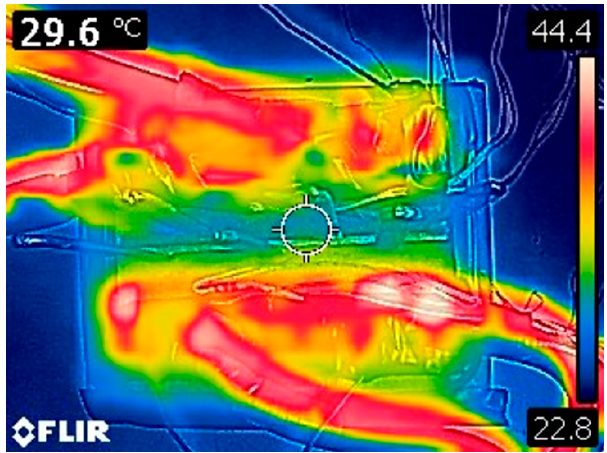
Figure 7. The temperature distribution of the heat pipe at the end of the cycling profile (3000 s).